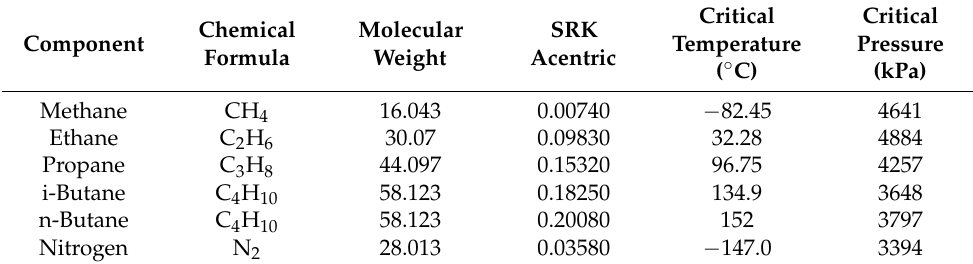
Table 4. Basic thermodynamic parameters of the NG components. SRK: Soave–Redlich–Kwong.